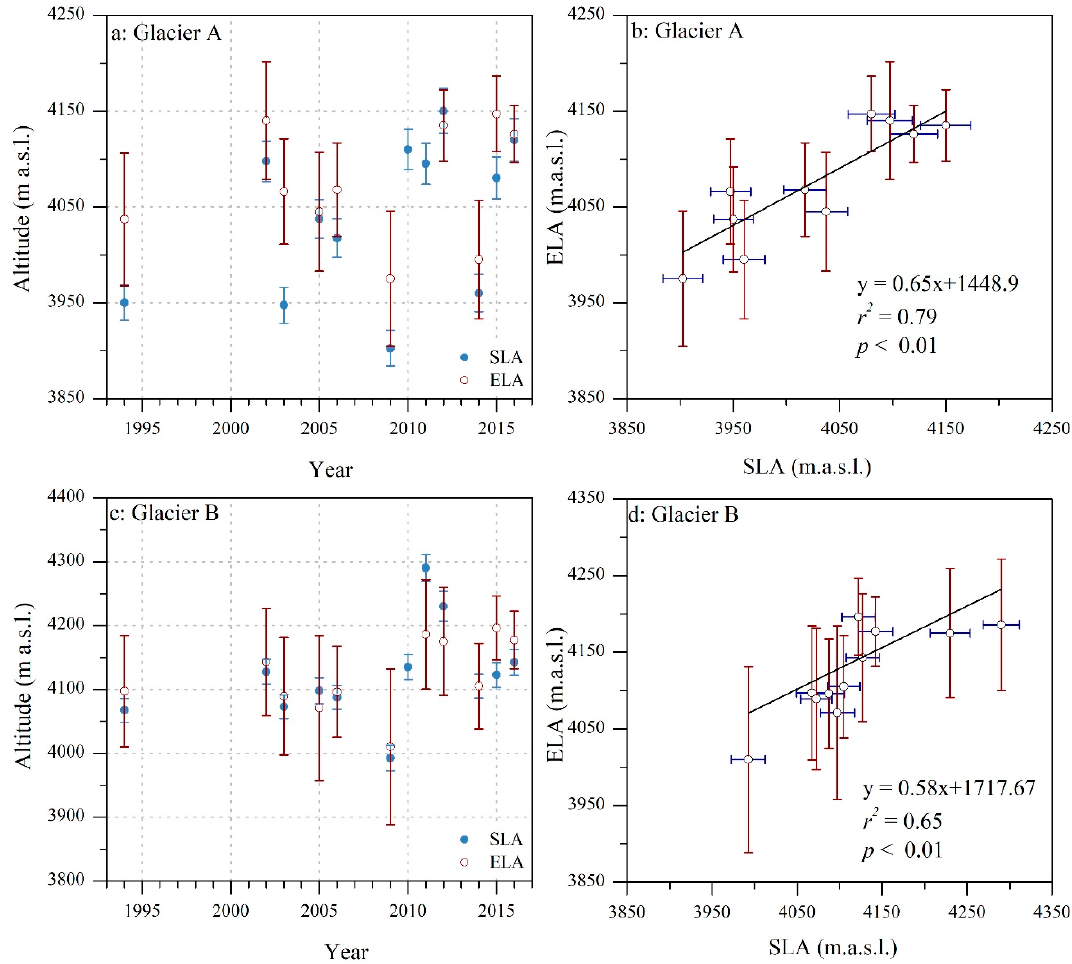
Figure 5. Snow line altitude (SLA) delineated from Landsat images compared to the equilibrium line altitude (ELA) measured in the field for glacier A ( a , b ) and glacier B ( c , d ). Vertical lines and horizontal lines represent the uncertainties.